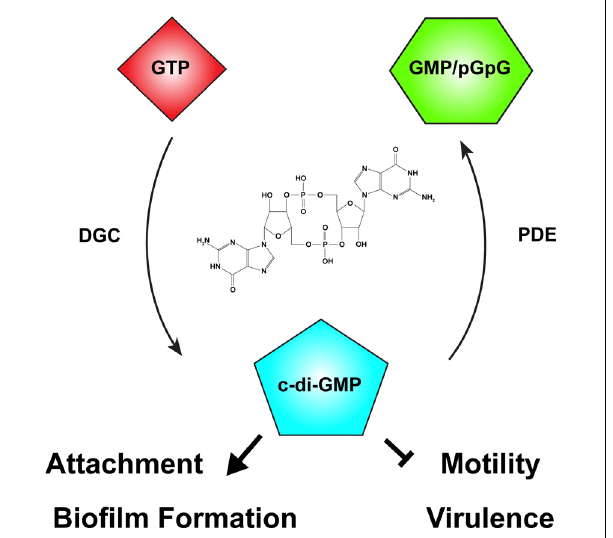
FIGURE 3 |The second messenger cyclic-di-GMP. Cyclic diguanylate monophosphate, or cyclic-di-GMP (c-di-GMP) is a common second messenger in prokaryotic systems. C-di-GMP is generated from two molecules of guanosine triphosphate (GTP) by diguanylate cyclases (DGC) and degraded by phosphodiesterases (PDE) to the linear form, 5 (cid:3) -phosphoguanylyl-guanosine (pGpG), and ultimately to two molecules of guanosine monophosphate (GMP). In many bacteria, including Agrobacterium tumefaciens , c-di-GMP levels reciprocally regulate the transition between motility and attachment. In A. tumefaciens globally or locally increased c-di-GMP levels positively regulate attachment and biofilm formation while negatively regulating motility.The effect of c-di-GMP on virulence in A. tumefaciens has not been described, although in many bacteria virulence is negatively regulated by elevated c-di-GMP levels.The chemical structure of c-di-GMP is included in the center of the